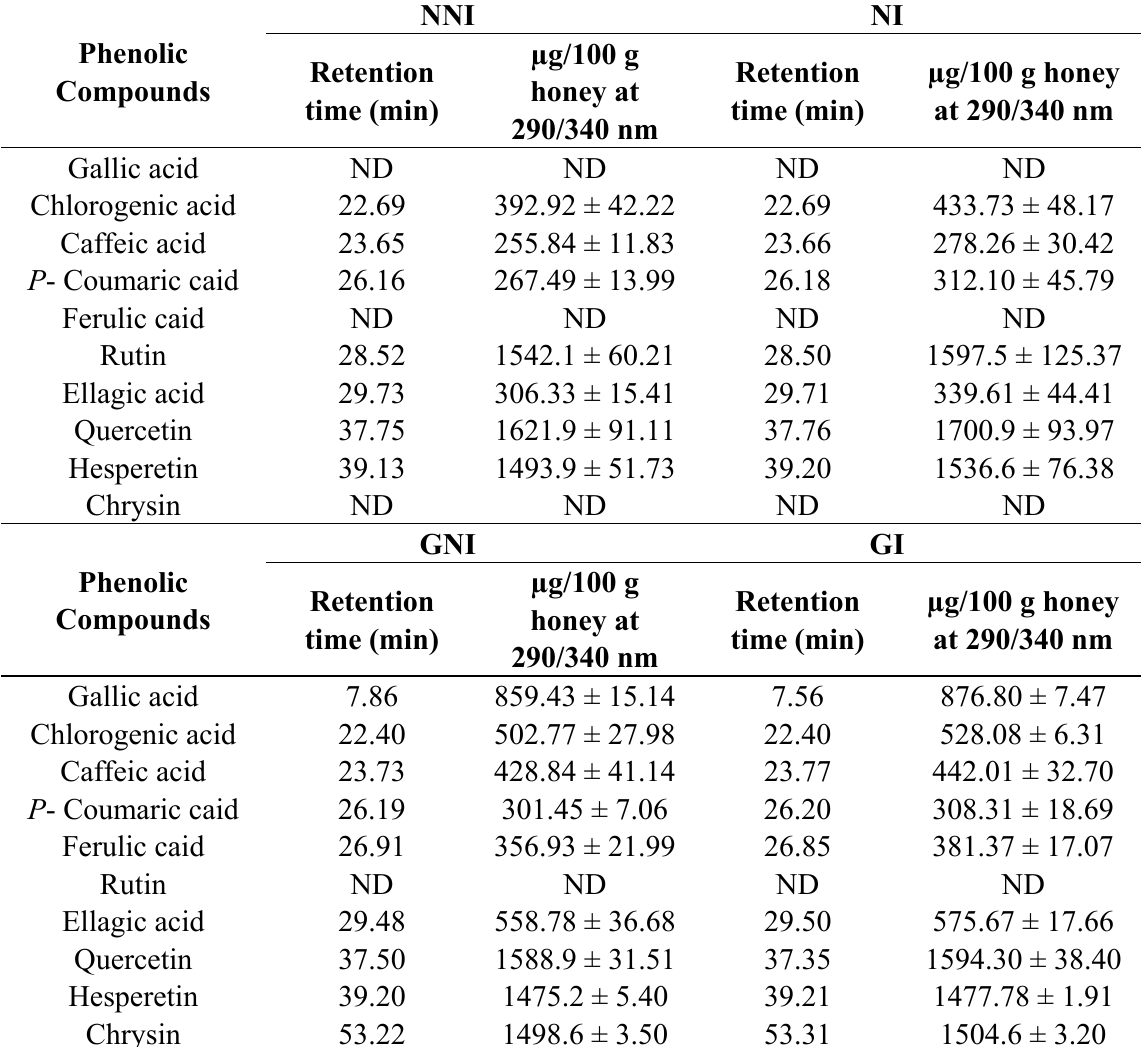
Table 6. Concentration of phenolic compounds detected in Gelam and Nenas honeys before and after irradiation by